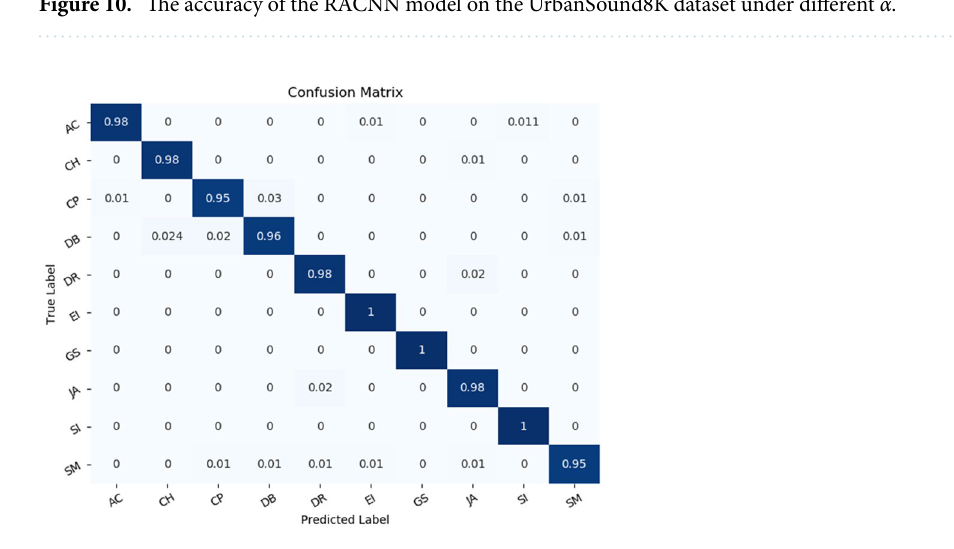
Figure 10. The accuracy of the RACNN model on the UrbanSound8K dataset under different α .